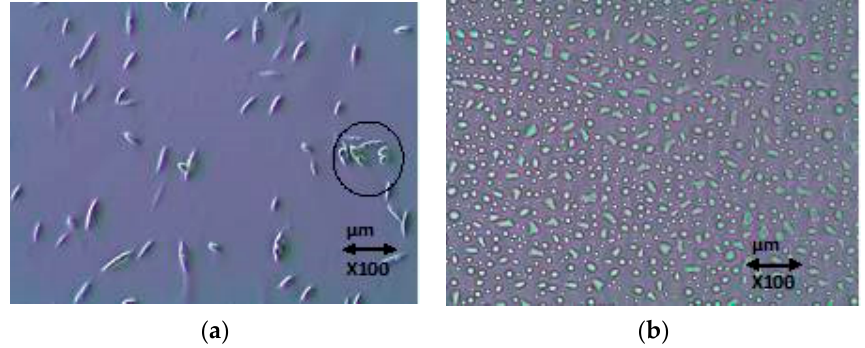
Figure 5. Magnified images of A. braunii , ( a ) non-burst, where the asexual reproduction of binary fission is shown in the circle, and ( b ) burst cells.